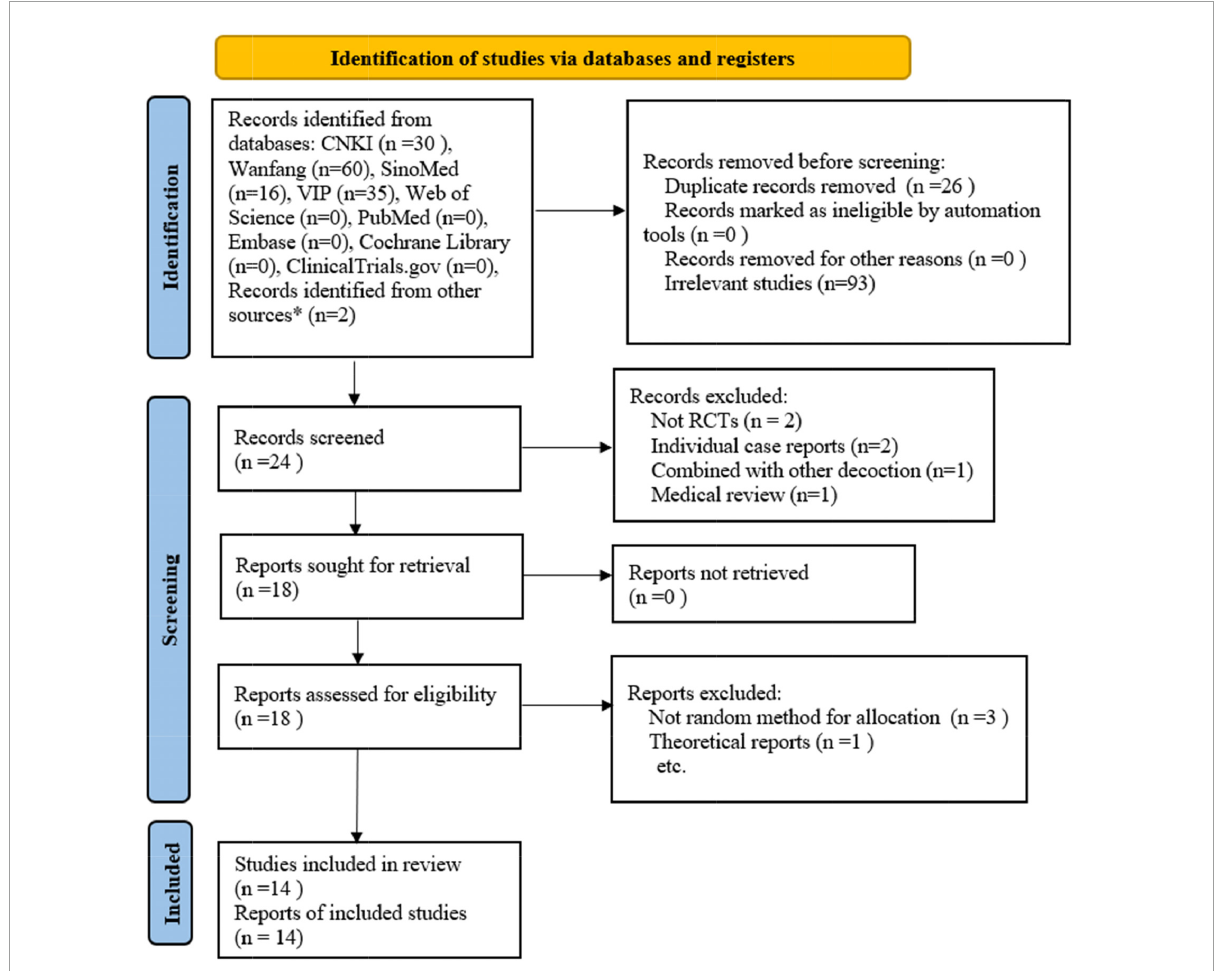
FIGURE1 Flow plot of the study selection process. * refers to studies identified from individual journals (Medicine and health, DA JIAN KANG). RCTs: randomized controlled trials. (Template for the flow plot was provided by PRISMA).